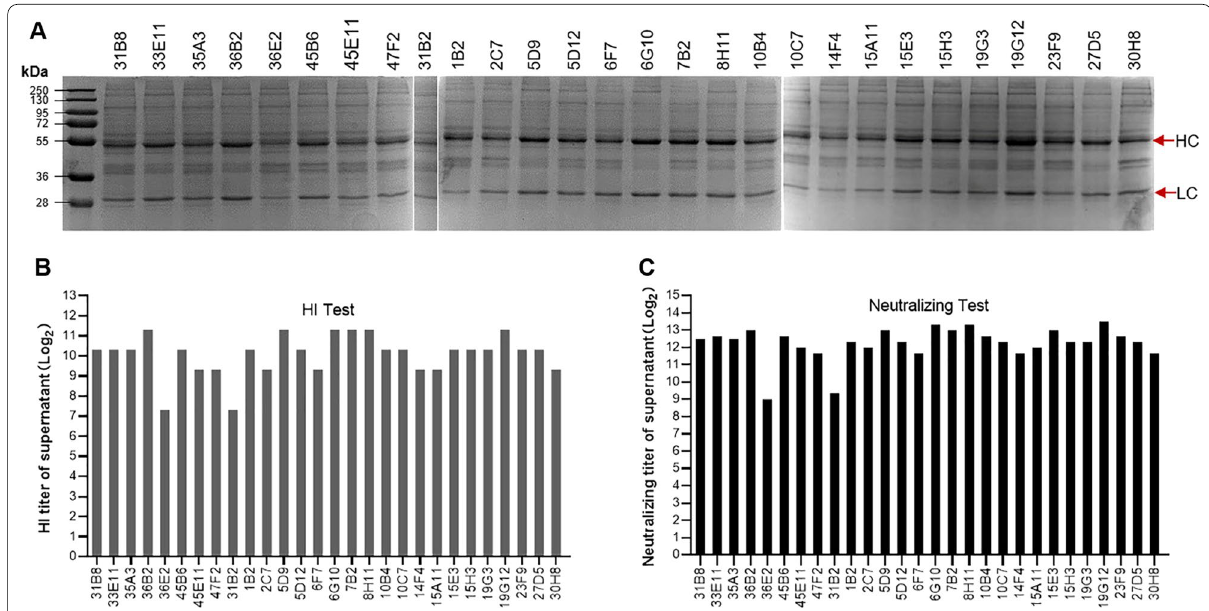
Fig. 4 Constriction of CHO-S cell line with chimeric antibody expression: selection round 1. HC (heavy chain), LC (light